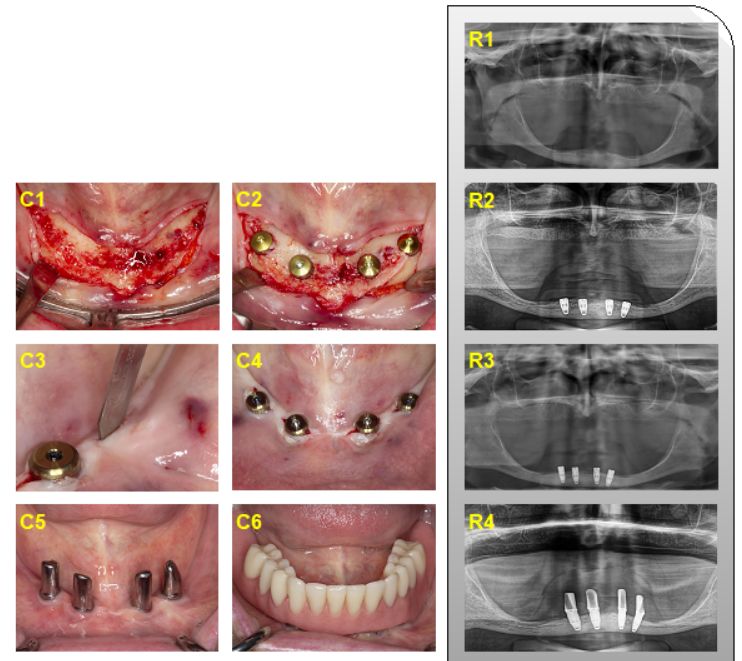
Figure 1. Clinical ( C1 – C6 ) and radiographic ( R1 – R4 ) presentation of iliac crest bone augmentation in the interforaminal region. ( C1 ) Intraoperative situs; ( C2 ) fixation of corticocancellous bone blocks; ( C3 ) removal of osteosynthesis screws after healing; ( C4 ) implant placement, ( C5 , C6 ) at the time of prosthetic reconstruction with; ( C5 ) suprastructure with a milled bar; and ( C6 ) final prosthesis in situ. ( R1 ) Preoperative situation, ( R2 ) after iliac crest bone augmentation, ( R3 ) after implant place- ment, and ( R4 ) follow-up after 11 years.